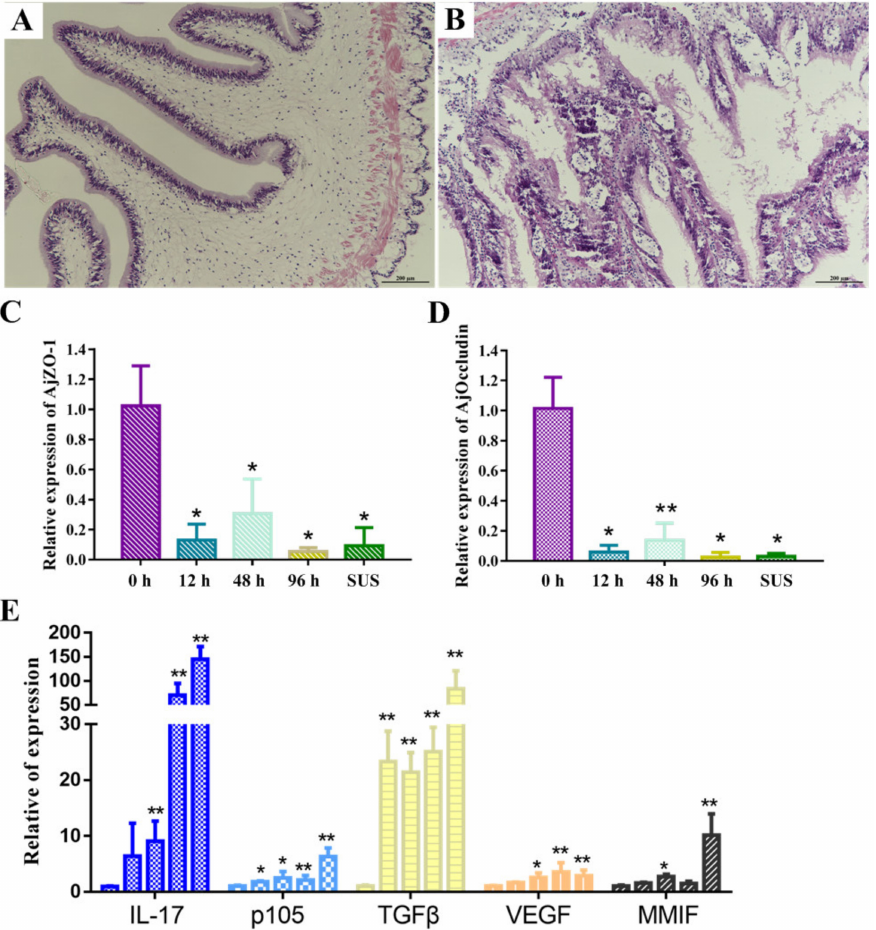
Figure 1. H&E staining of the intestinal tissue sections of ( A ) the 0 h group and ( B ) the SUS group. Temporal expression of tight junction proteins in V. splendidus -infected sea cucumber intestinal tract: ( C ) AjZO-1 and ( D ) Ajoccludin. ( E ) The expression of inflammatory factors IL-17, p105, TGF β , VEGF, MMIF at different infectious times of A. japonicus infected with V. splendidus , with a final concentration of 1 × 10 7 CFU mL − 1 . Asterisks indicate significant differences: * p < 0.05 and ** p <